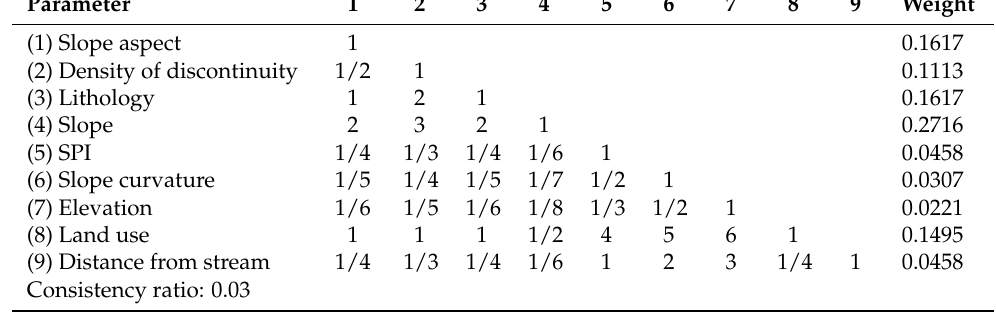
Table 4. Pair-wise comparison matrix, factor weights and consistency ratio of the data layers. Parameter